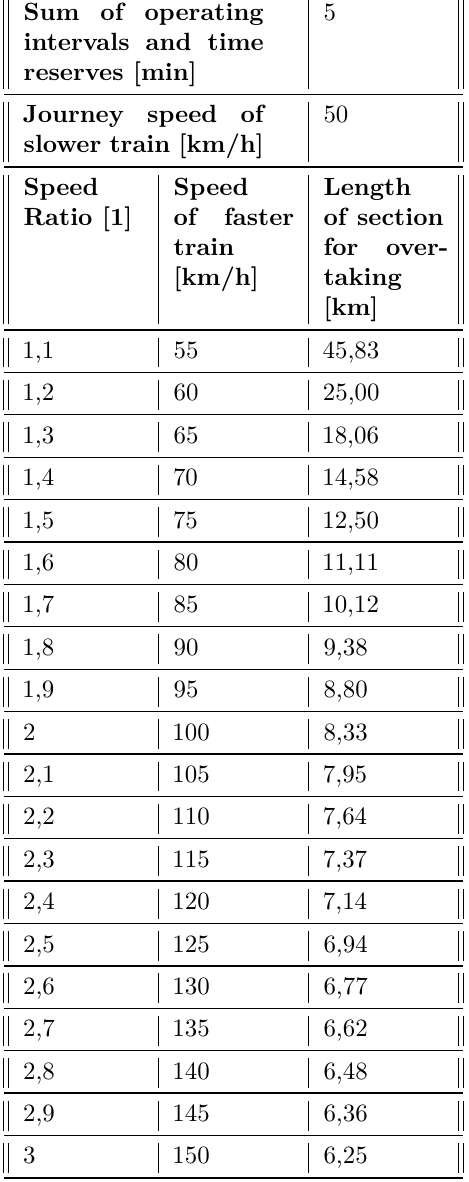
Table 1. Length of section for